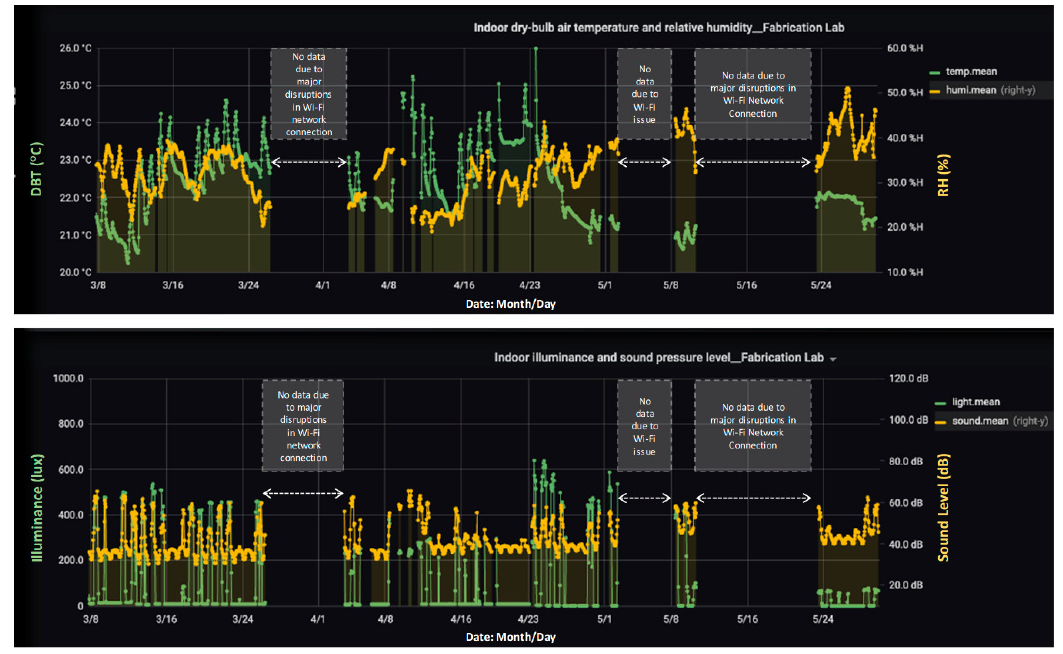
Figure 12. DBT, RH, Illuminance and Sound levels—Historic Data Visualisation at the Print Office (source: IoT data display in Grafana tool, edited by the author).